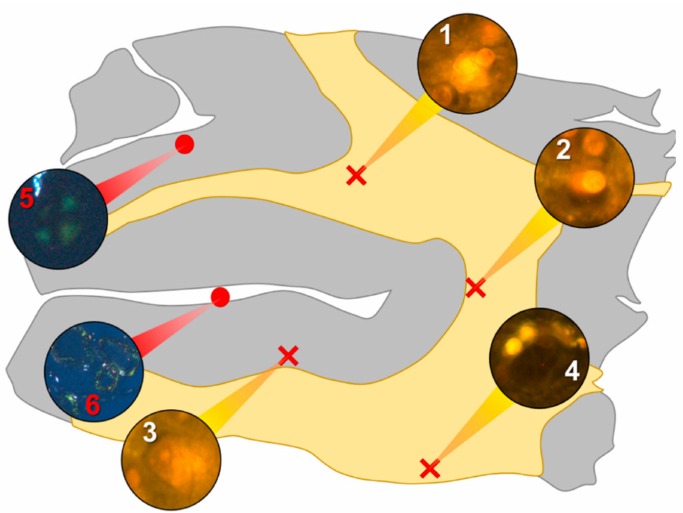
Figure 1. Schematic depicting a 5 µ m tissue section of the parietal lobe. White matter and grey matter are highlighted yellow and grey, respectively. Lumogallion-reactive aluminium was identified through sequential scanning of a 5 µ m tissue section, with positive bright orange fluorescence denoted by red crosses (regions 1–4). On an adjacent serial section, Congo red positive regions showing apple-green birefringence under polarised light identified amyloid and spherulites, denoted by red circles (regions 5 and 6).